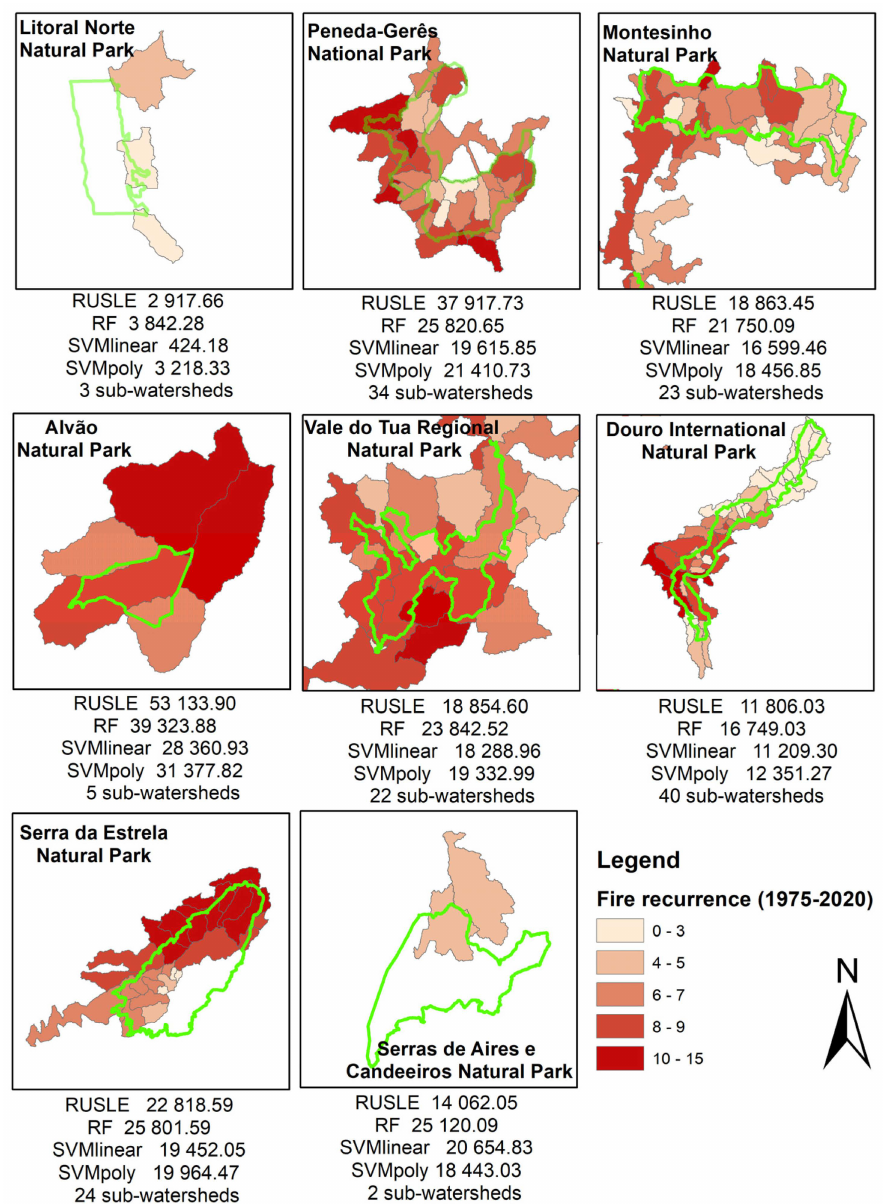
Figure 5. Results in sub-watersheds included in PA in four hydrographic regions. * They are at the limit of the hydrographic regions and therefore only the sub-watersheds located in the selected hydrographic regions are not analyzed.